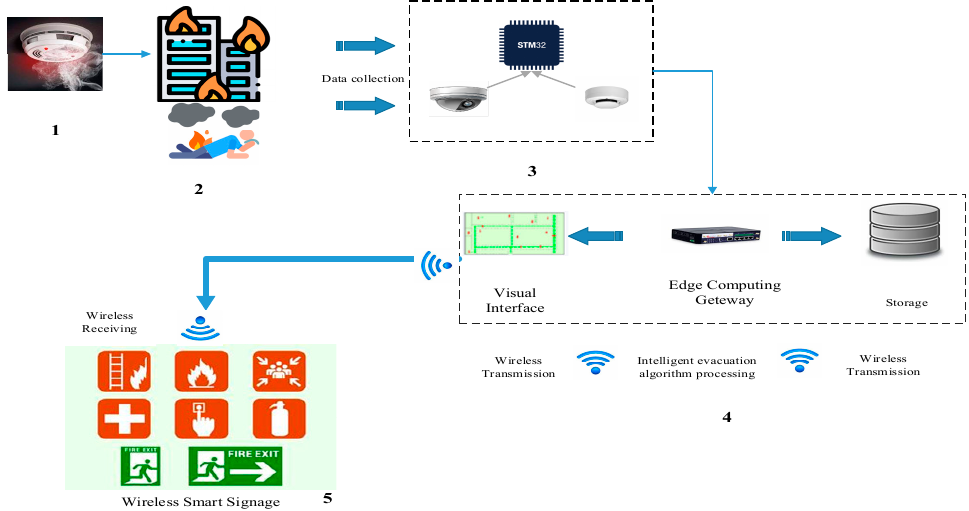
Figure 1. A fire evacuation and control system architecture in smart buildings based on IoT.